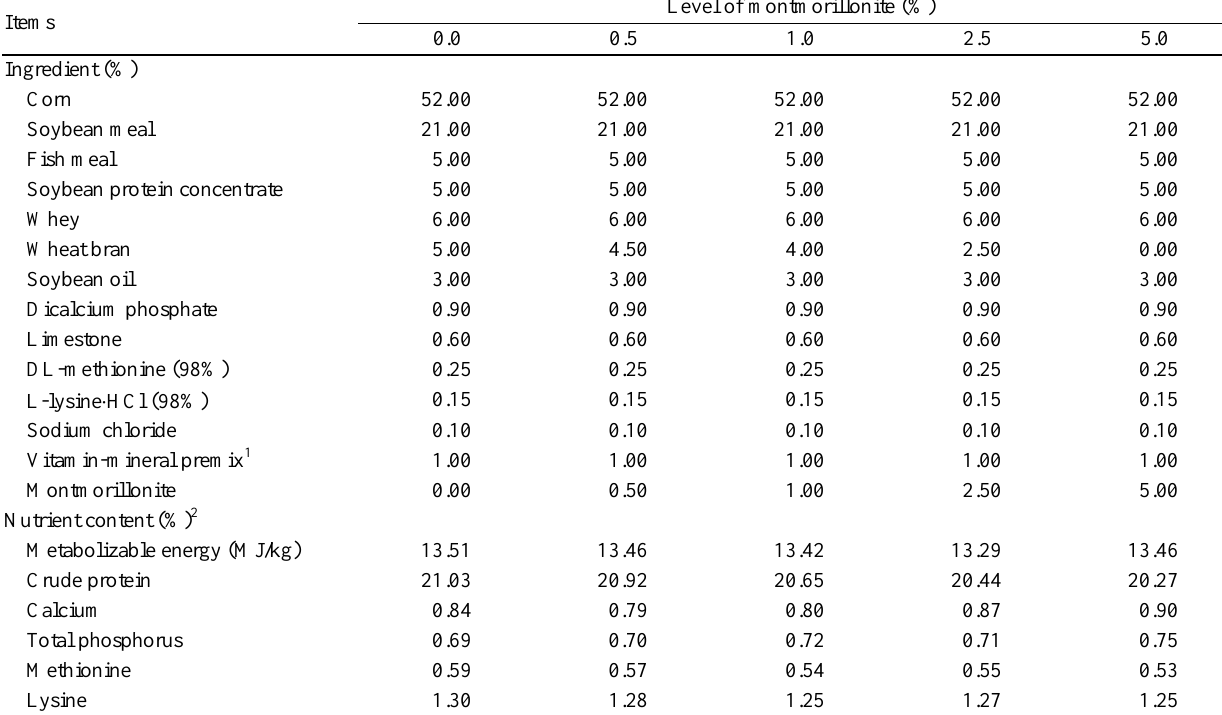
Table 1. Ingredient composition and nutrient content of experimental diets (% as-fed basis)